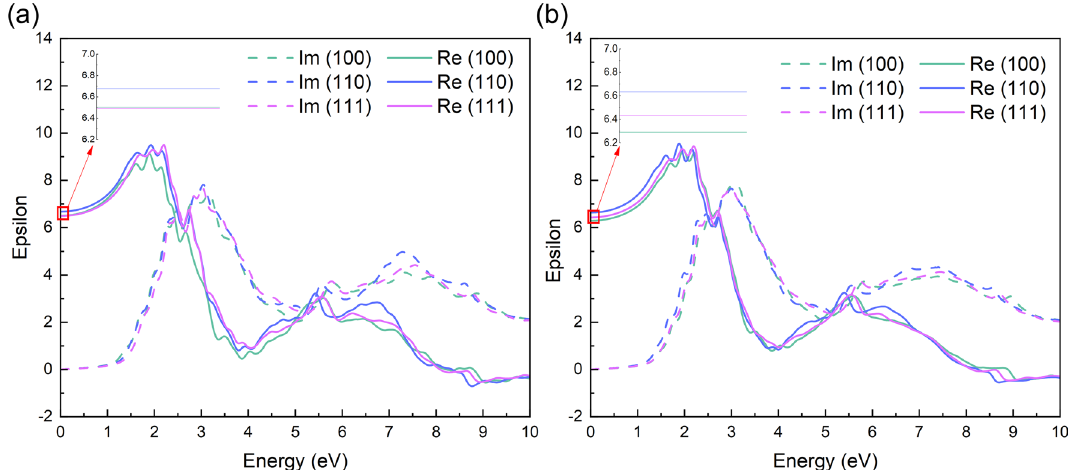
Figure 7. The real and imaginary part of dielectric function of ( a ) FAPbI 3 and ( b ) FA 0.875 Cs 0.125 PbI 3 with different FA cations